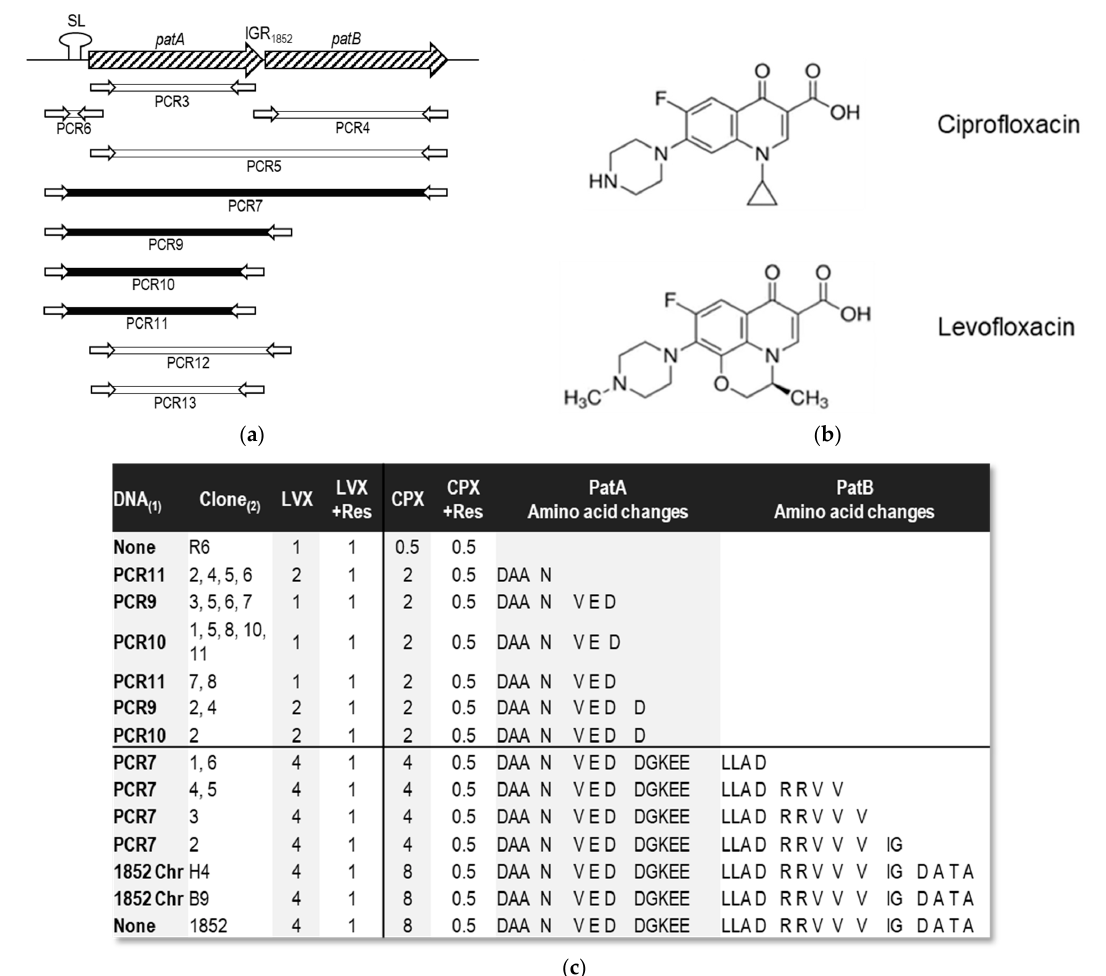
Figure 4. R6 CPX-resistant transformants obtained with PCR fragments amplified from SPN1852. ( a ) Scheme of the patAB operon of SPN1852 and its upstream region, and the PCR amplimers used. Genes are represented by dashed arrows and the stem-loop (SL) in the upstream region is illustrated. PCR fragments used in transformation (rectangles) and the corresponding primers (white arrows, not drawn to scale) are shown. Those rendering CPX-resistant transformants are depicted in black; ( b ) chemical structures of ciprofloxacin and levofloxacin; ( c ) table showing the MICs for transformants of LVX and CPX in the presence (+R) or absence of Res. PCR fragments used as donors (1) and clone numbers (2) are indicated. SPN1852 amino acid changes present in PatA and PatB proteins of each transformant are shown.